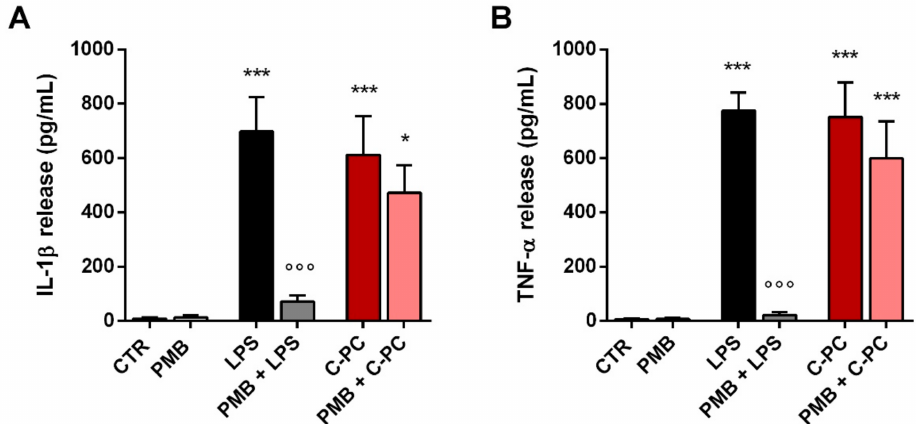
Figure 5. Effect of polymyxin B on cytokine release from cortical microglia. Microglia were cultured overnight in medium containing 10% of serum, which was replaced with serum-free medium before pretreatment with 50 µ g/mL polymyxin B (PMB) for 1 h followed by stimulation with LPS (100 ng/mL) or C-PC (100 µ g/mL) for 16 h. Supernatant were collected and analyzed for IL-1 β ( A ) and TNF- α ( B ) content. Data are means ± SEM ( n = 4 in triplicate). * p < 0.05 and *** p < 0.001 versus control cells. ◦◦◦ p < 0.001 versus LPS treatment (black bars). One-way ANOVA followed by Holm–Sidak’s test.